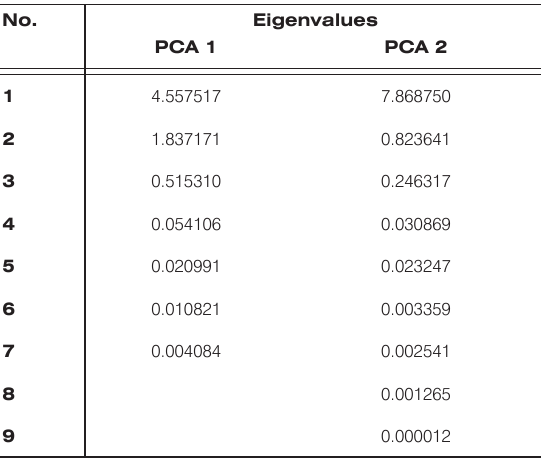
Table 6. Eigenvalues of various PCA. PCA 1 corresponds to Fig. 2 and PCA 2 corresponds to Fig. 3.